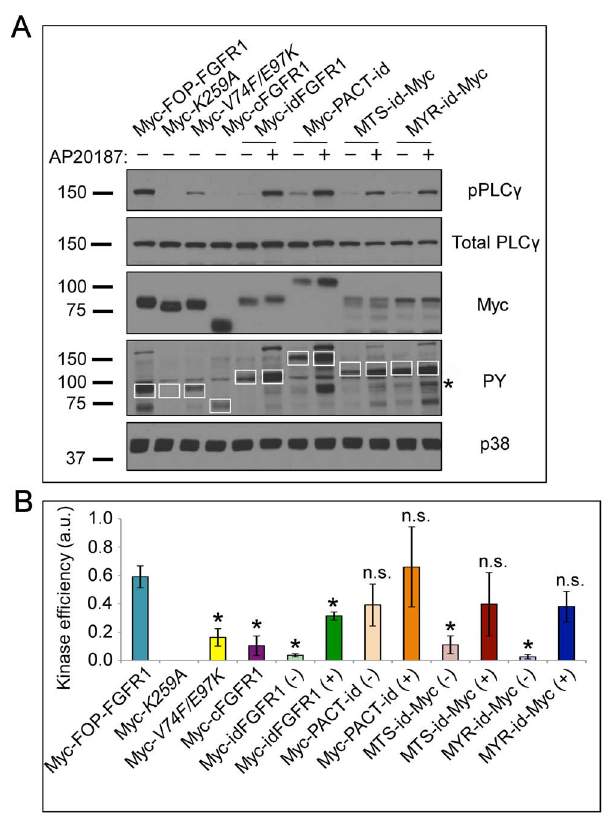
Figure 3. Dimerization and subcellular targeting are required in FGFR1 MPN signaling. ( A ) WB analysis of lysates from RPE-1 cells transfected with Myc-FOP-FGFR1, Myc-FOP-FGFR1 K259A , Myc-FOP- FGFR1 V74F/E97K , Myc-cFGFR1, Myc-idFGFR1, Myc-PACT-idFGFR1, MTS- idFGFR1-Myc, or MYR-idFGFR1-Myc, treated with 10 nM AP20187 or vehicle (100% ethanol) for 24 h in low serum medium, harvested, and probed with antibodies against phospho-PLC c (pPLC c ), total PLC c , Myc, PY, and p38 as a loading control. White boxes indicate quantified regions in PY blot, * marks a non-specific band present in all lanes. ( B ) Graph showing kinase efficiency of each construct with or without AP20187 addition. Kinase efficiency = WB signal intensity of (pPLC c / PLC c )/PY. Quantifications were obtained using a Typhoon imaging system and fluorescence-conjugated secondary antibodies. Bars repre- sent mean of 3 independent trials 6 SEM. *p , 0.05, n.s. p .